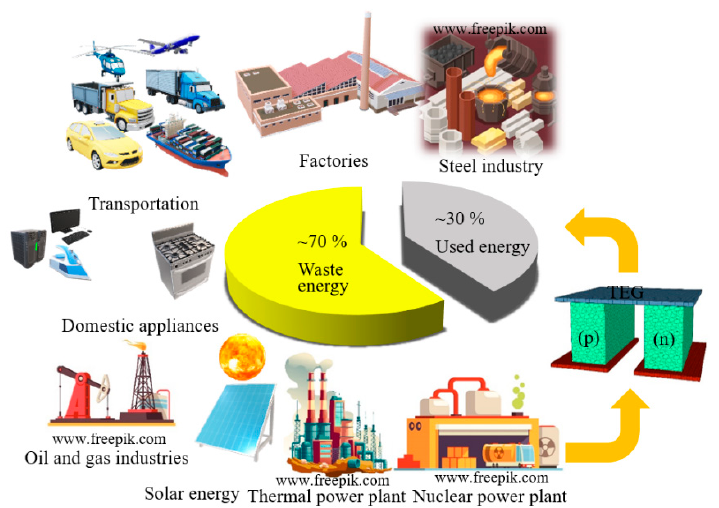
Figure 10. Schematic illustration of several sources of waste thermal energy and waste heat recycling by thermoelectric generators.